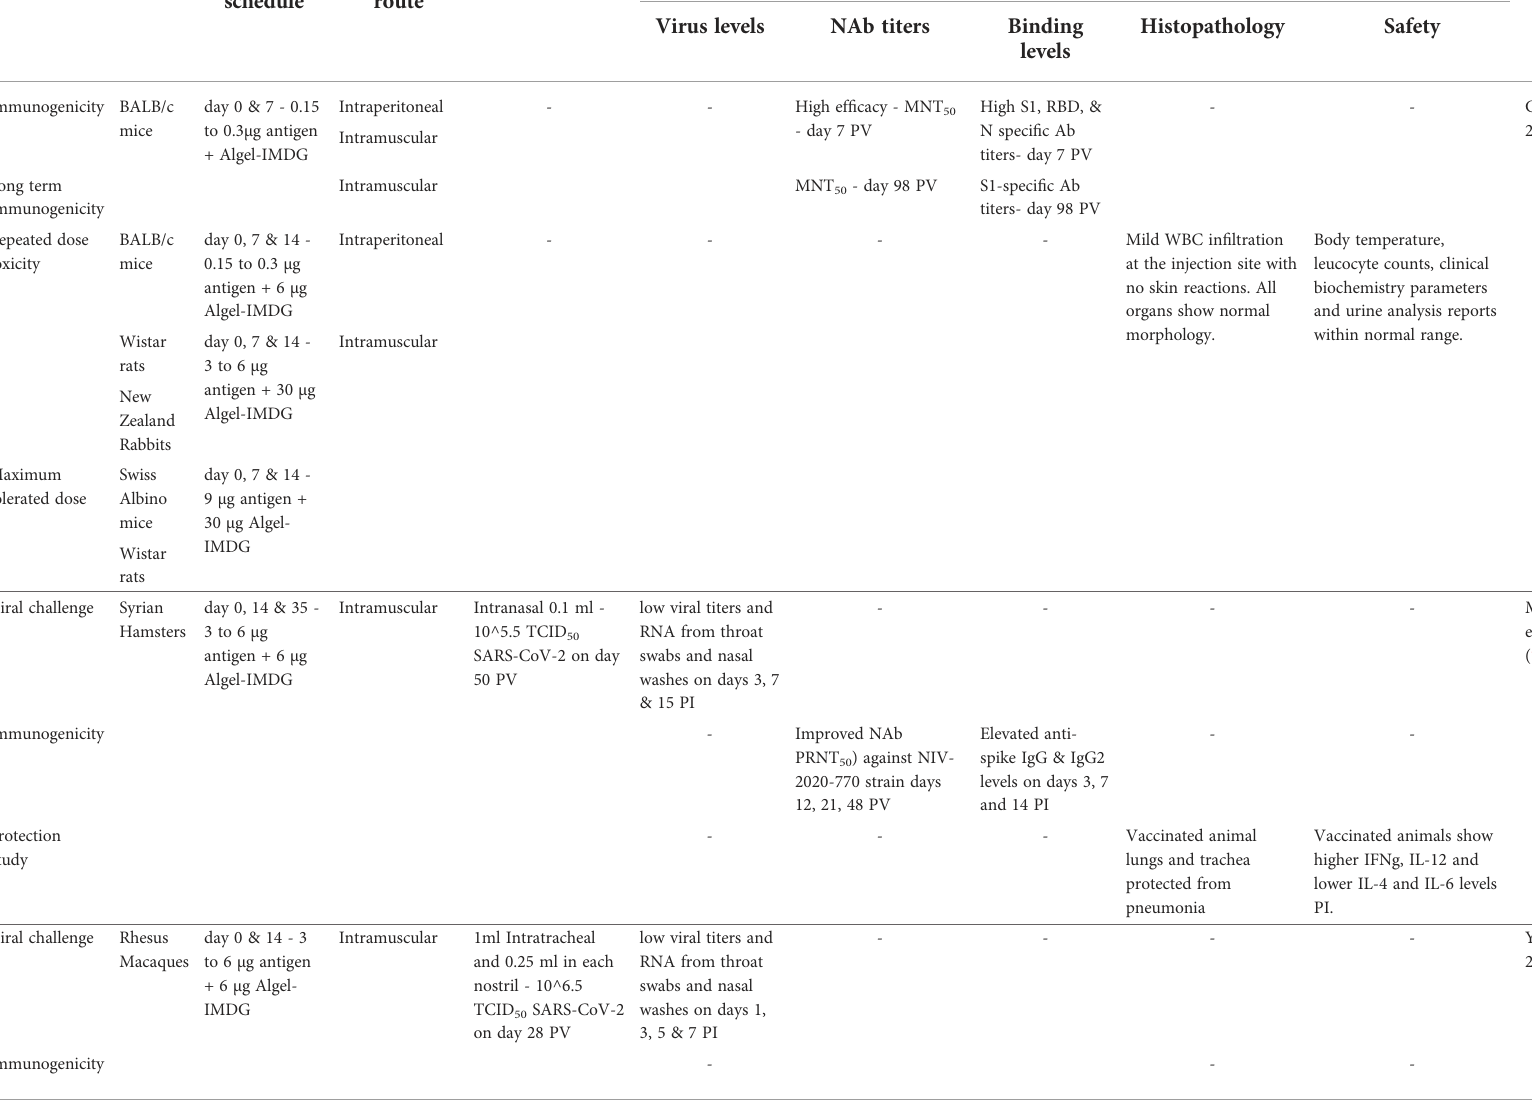
TABLE 1 BBV152 preclinical immunogenicity and safety